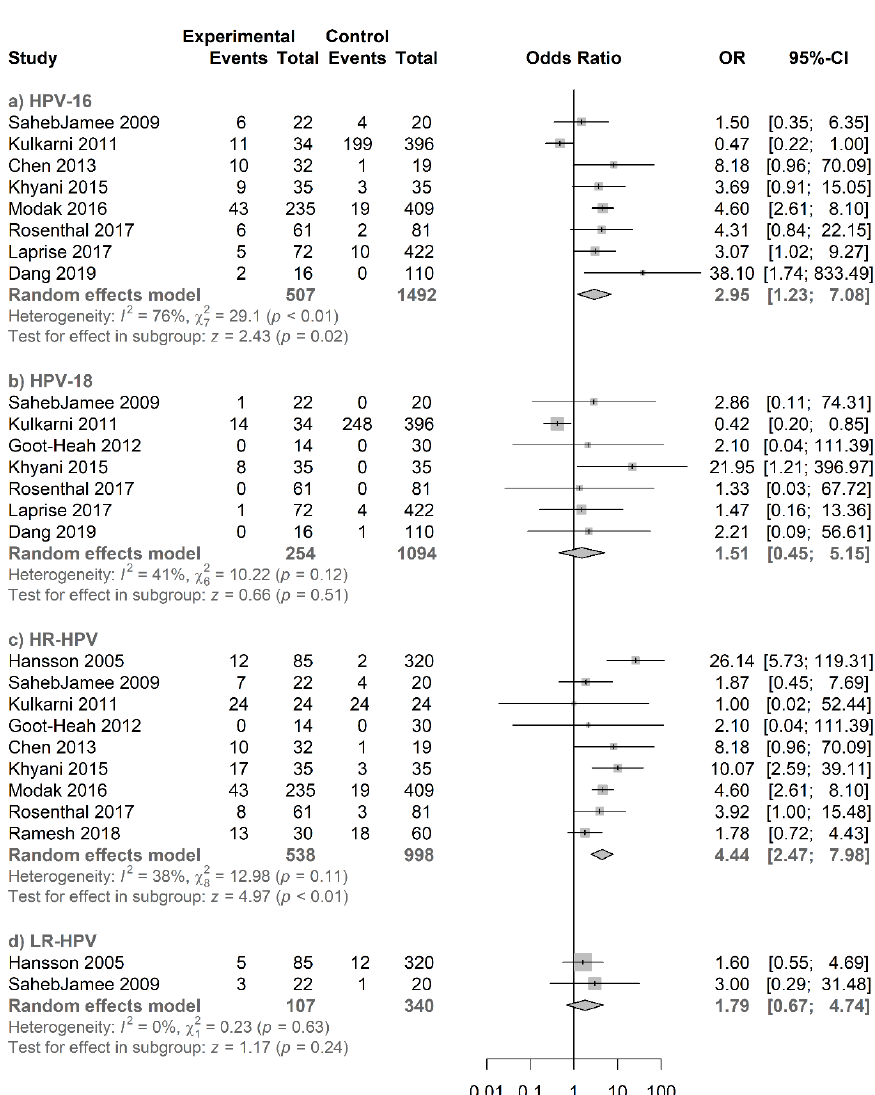
Figure 8. Forest plot for the studies on the association between salivary HPV and oral cancer. The squares indicate the ORs in each study, with square sizes inversely proportional to the standard error of the OR. The diamond shape indicates the pooled ORs. Horizontal lines represent 95% CIs. I2 > 50% indicates severe heterogeneity. ( a ) HPV16, ( b ) HPV18, ( c ) HR-HPV, and ( d ) LR-HPV.